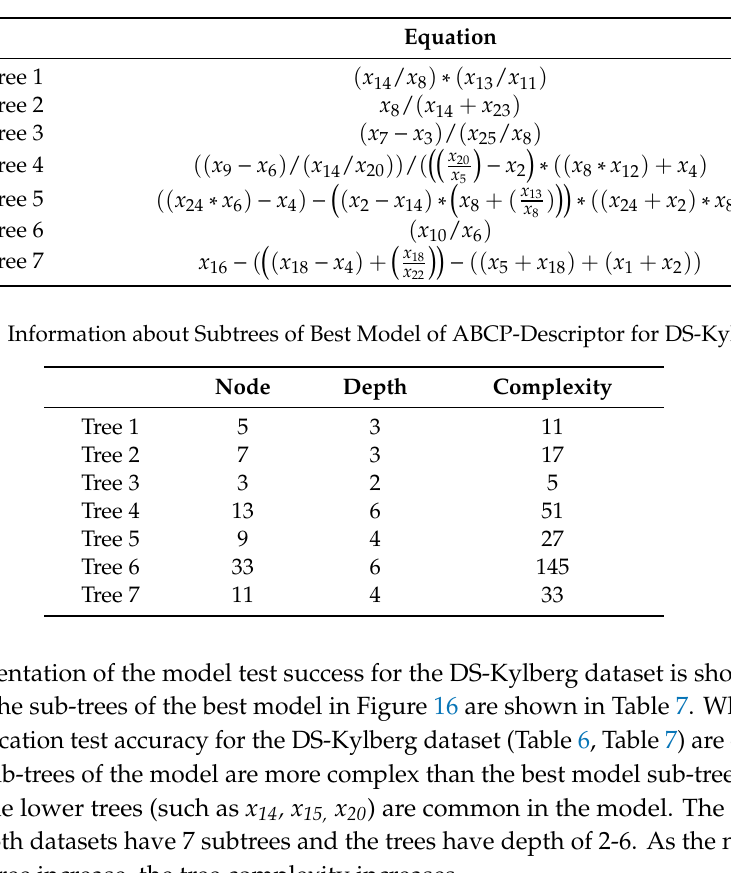
Table 5. Equations of Subtrees of Best Model of ABCP-Descriptor for DS-Broadtz.